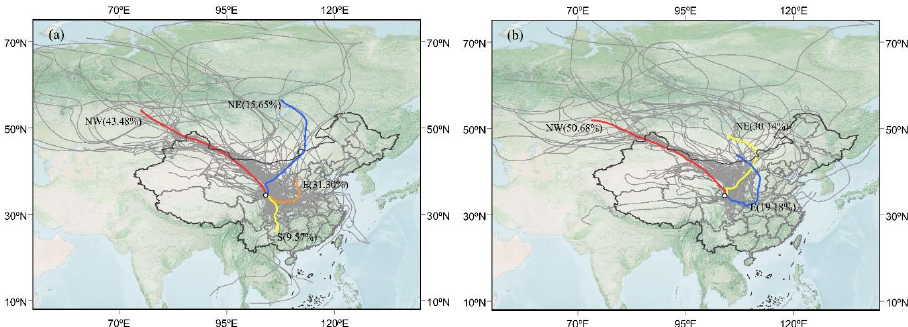
Figure 6. Cluster analysis of water sources in Minxian Station in the summer half-year ( a ) and winter half-year ( b ), the colored lines are the clustering results, and the gray lines are the water vapor trajectory.